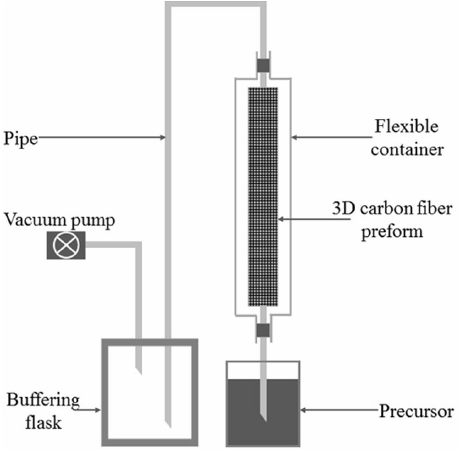
Fig. 1 Schematic diagram of modified infiltration